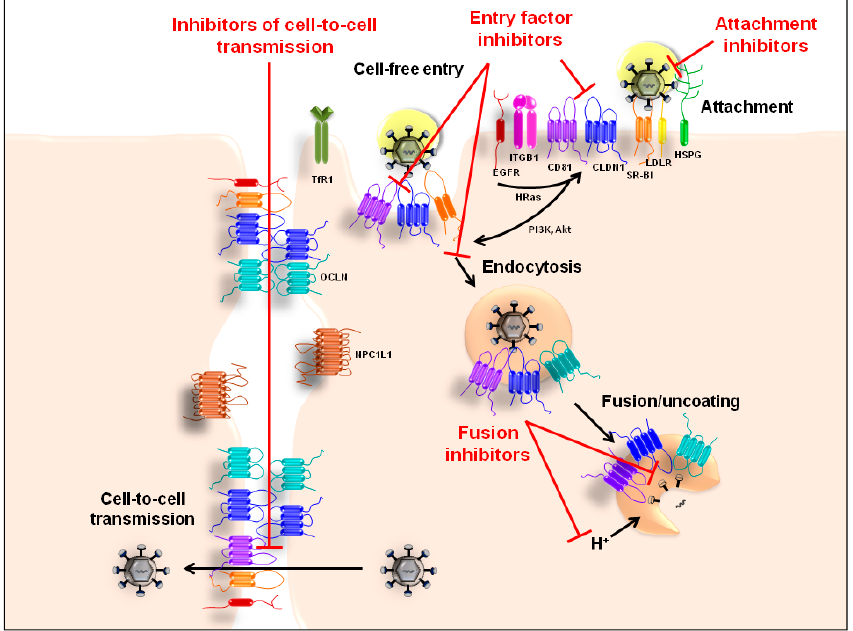
Figure 2. Schematic representation of HCV entry. The initial viral attachment on the basolateral membrane of hepatocytes is believed to involve the interaction of the viral particle—both viral (HCV envelope glycoproteins) and host ‐ derived (apolipoproteins) factors—with HSPGs (heparan sulfate proteoglycans), LDLR (low density lipoprotein receptor) and SR ‐ BI (scavenger receptor class B type I). Following interaction between the virus and different host factors expressed at the hepatocyte cell surface, including CD81 (cluster of differentiation 81) and CLDN1 (claudin 1), as well as rearrangement of cell surface proteins, the virus is ultimately internalized into its host cell via clathrin ‐ mediated endocytosis. Additional host factors, including EGFR (epidermal growth factor receptor), NPC1L1 (Niemann ‐ Pick C1 ‐ like 1) and TfR1 (transferrin receptor 1), contribute to the HCV entry process, for example by modulating intracellular signaling pathways or endocytosis. Following acidification of the endosome and subsequent fusion of viral and endosomal membranes, the viral genome is released into the cytoplasm. In addition to cell ‐ free virus entry, HCV has also been described to transmit between hepatocytes through direct cell ‐ to ‐ cell transmission involving CD81, SR ‐ BI, CLDN1, OCLN (occludin), EGFR, EphA2 (ephrin receptor A2) and NPC1L1. HTAs can interfere with different steps of the HCV entry process as highlighted in red.